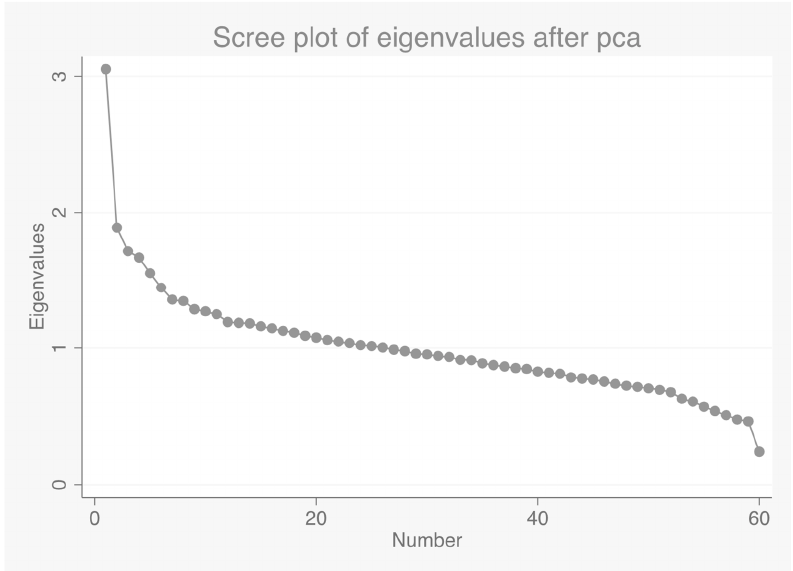
Figure 1. Scree plot for identification of dietary patterns by principal component analysis. Food intakes (g/day) were aggregated into 60 food groups. An eigenvalue >1.5 was selected as the cut-off for retaining the components.